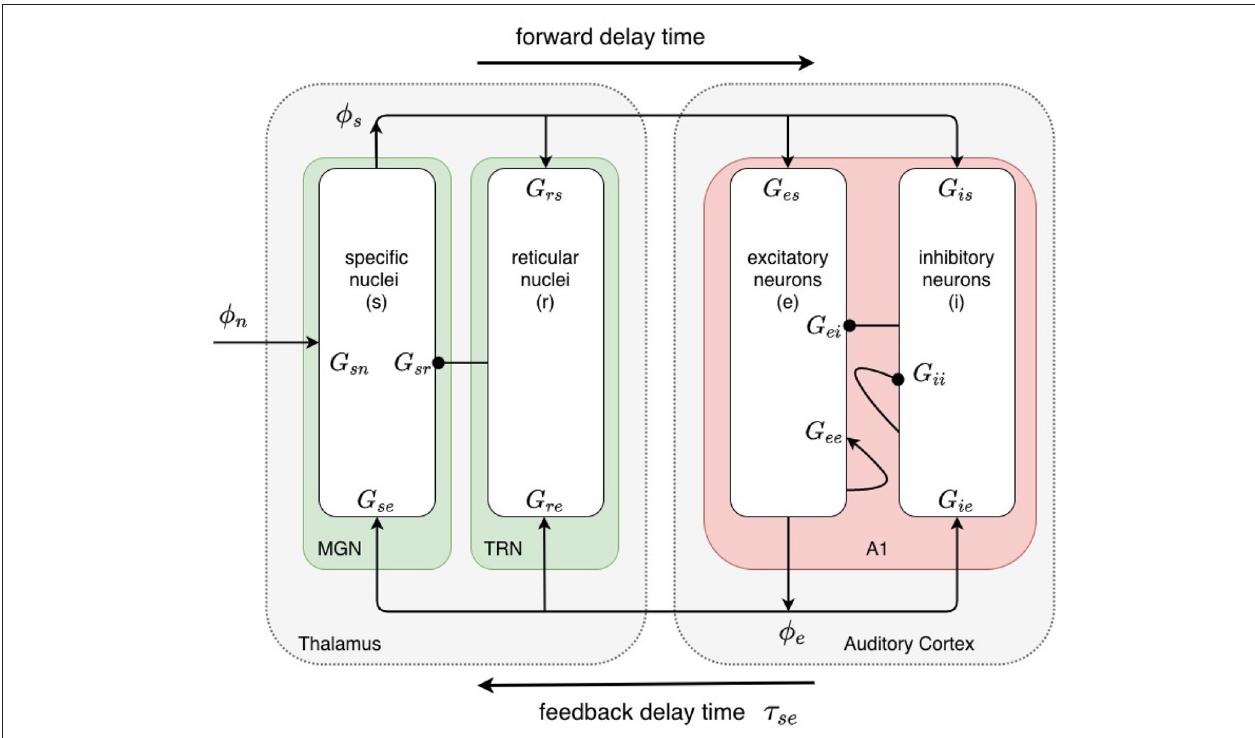
FIGURE 2 | Physiologically based corticothalamic neural field model. Arrowheads represent excitatory effects while circles depict inhibitory ones. The populations are cortical excitatory ( e ) and inhibitory ( i ) neurons, the thalamic reticular nucleus (TRN, r ), thalamic relay neurons in the medial geniculate nucleus (MGN, s ) that project to the primary auditory cortex (A1), and non-corticothalamic neurons responsible for external inputs ( n ).